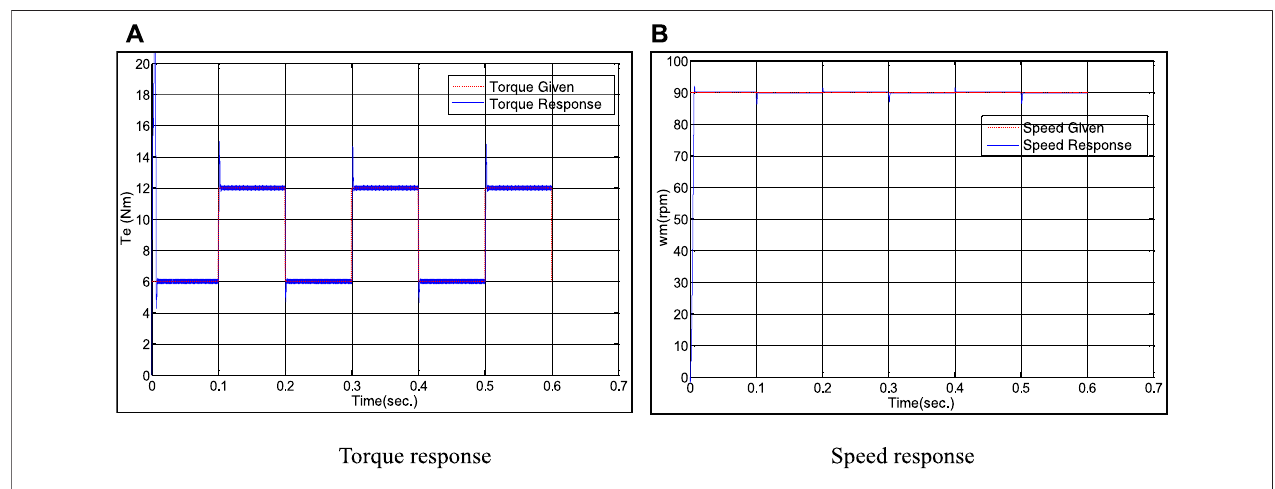
FIGURE 7 | Response curve of BPNN inverse system decoupling control when torque changes periodically.